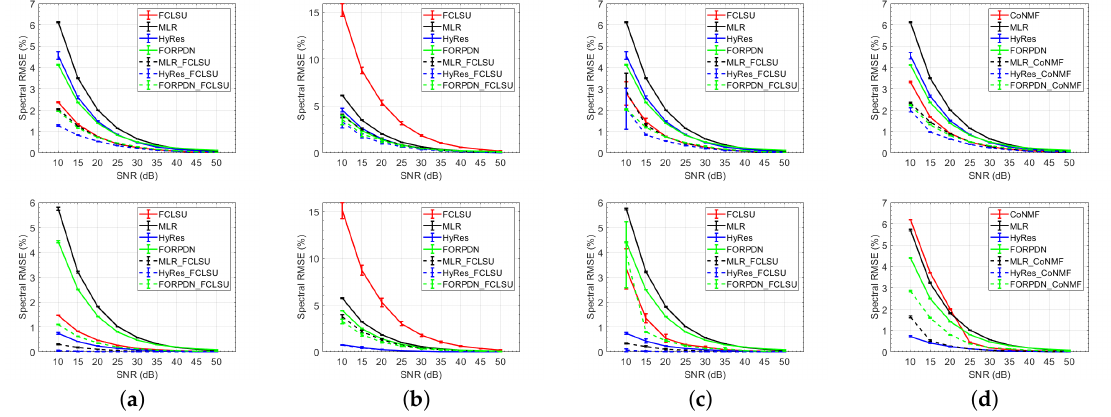
Figure 6. Simulated data (top row η = ∞ and bottom row η = 18): The denoising performance of spectral unmixing compared with the denoising techniques. ( a ) Ground truth endmembers; ( b ) extracted endmembers; ( c ) library endmembers; ( d ) estimated